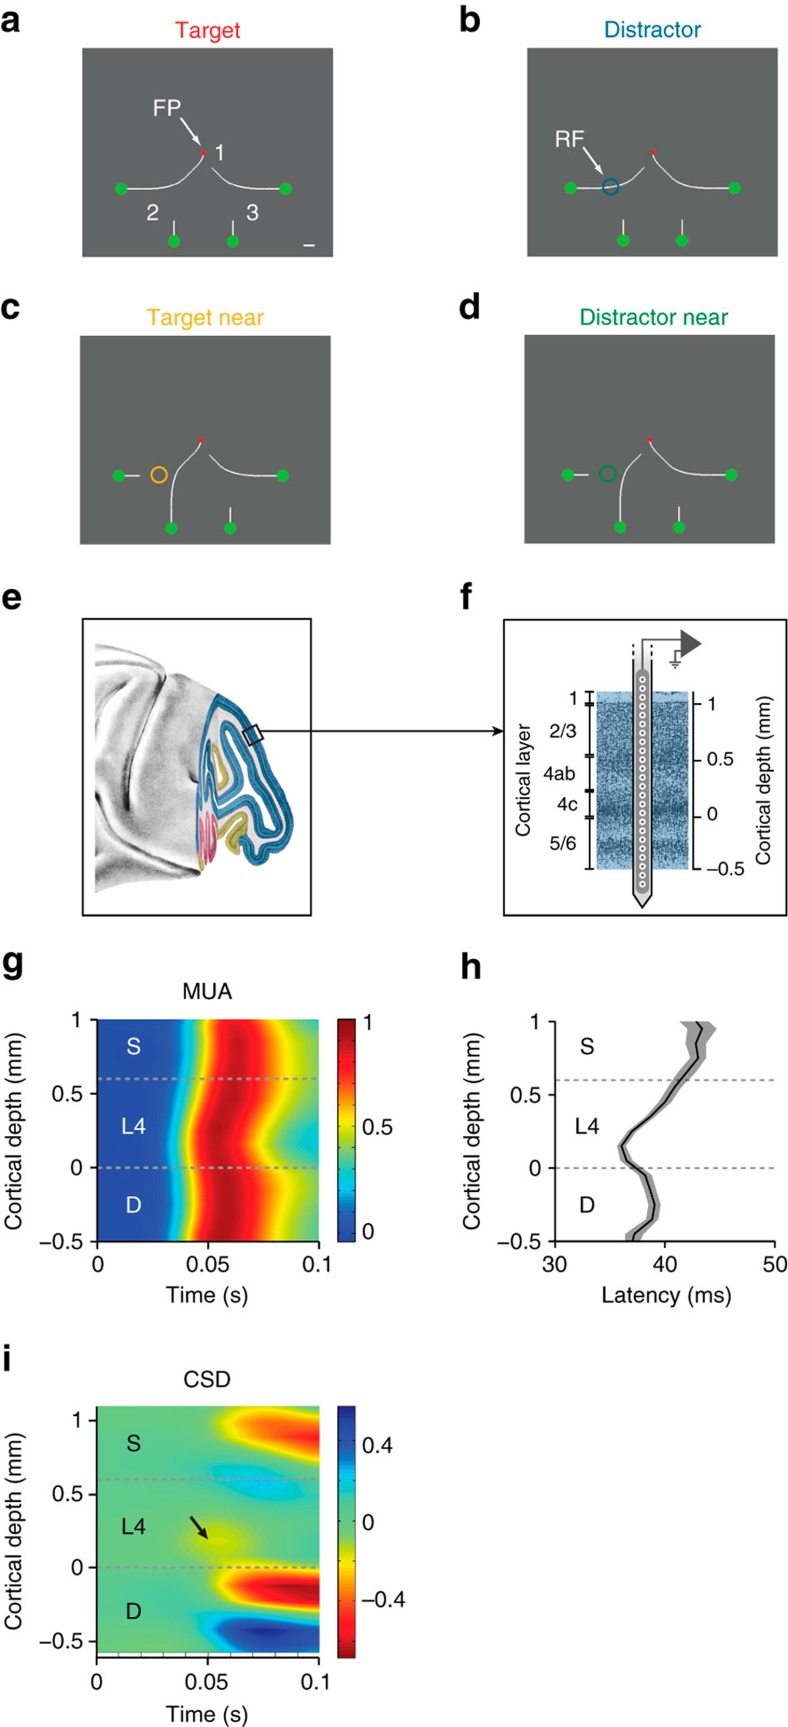
Laminar recordings and visual stimuli.(a–d) The monkey had to mentally trace the target curve that was connected to the fixation point (FP), and to make an eye movement to the green circle at the end of this curve. We placed the target curve (a) or a distractor curve in the RF (b). In other conditions the target (c) or distractor curve (d) was next to the RF. Circles, RFs. Bar in a, 1°. (e) Lateral view of the macaque brain. V1 is the blue region. (f) Laminar recording with the multi-site linear electrode (Plexon Inc. U-probe). (g) The average MUA response evoked by the onset of the target curve across the layers. Note the slight differences in the timing of the onset of the MUA response between layers. (h) Visual latencies in the different layers, averaged across all penetrations, shaded areas indicate s.e.m. (n=38 penetrations). The earliest neuronal activity occurred in layers 4C and 6. (i) Average CSD evoked by the appearance of the target curve. Warm colours indicate current sinks, cooler colours current sources. The appearance of the curve causes an early sink in layer 4C (arrow). (e,f) Adapted from ref. 39.